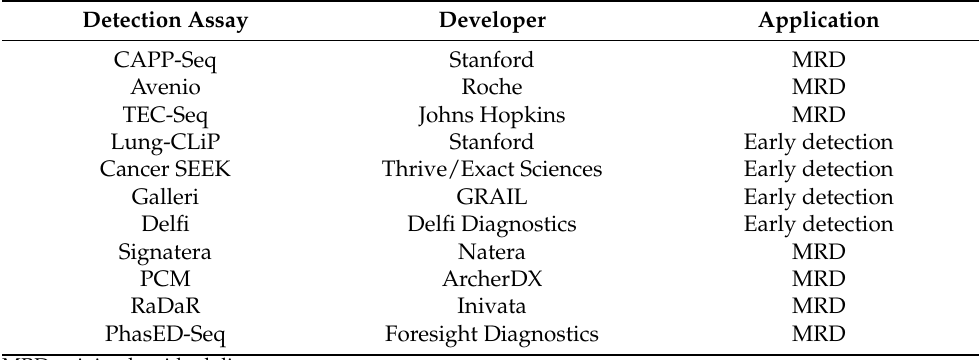
Table 1. Novel MRD and early detection assays in development for lung